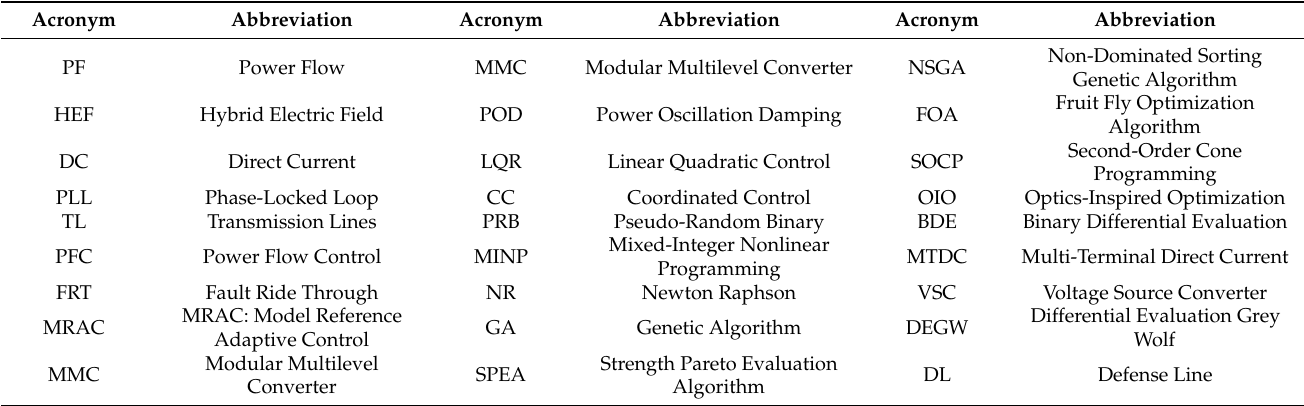
Table 1. Abbreviations of acronyms used in the paper.